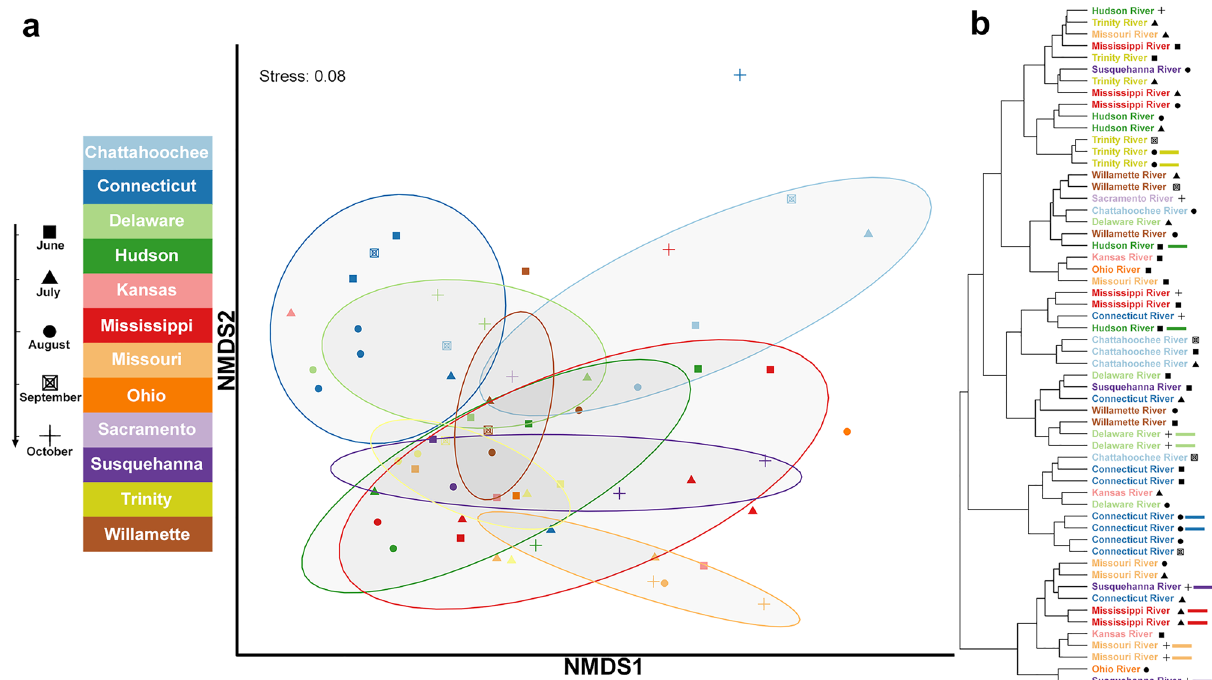
Figure 2. Beta diversity of microbial community composition in U.S. river samples. ( a ) Non-metric multidimensional scaling (NMDS) plot of Bray–Curtis distances for each sample. Points are colored by river, with different shapes representing month (see legend on left). Colored ellipses with confidence levels of 67% were generated for each river with more than two points. ( b ) Cluster diagram of all samples based on Bray– Curtis distance and complete agglomeration clustering algorithm. Month of sample is indicated by shape. Colored bars to the right of samples indicate sequential replicates (replicates are all pairs of samples).